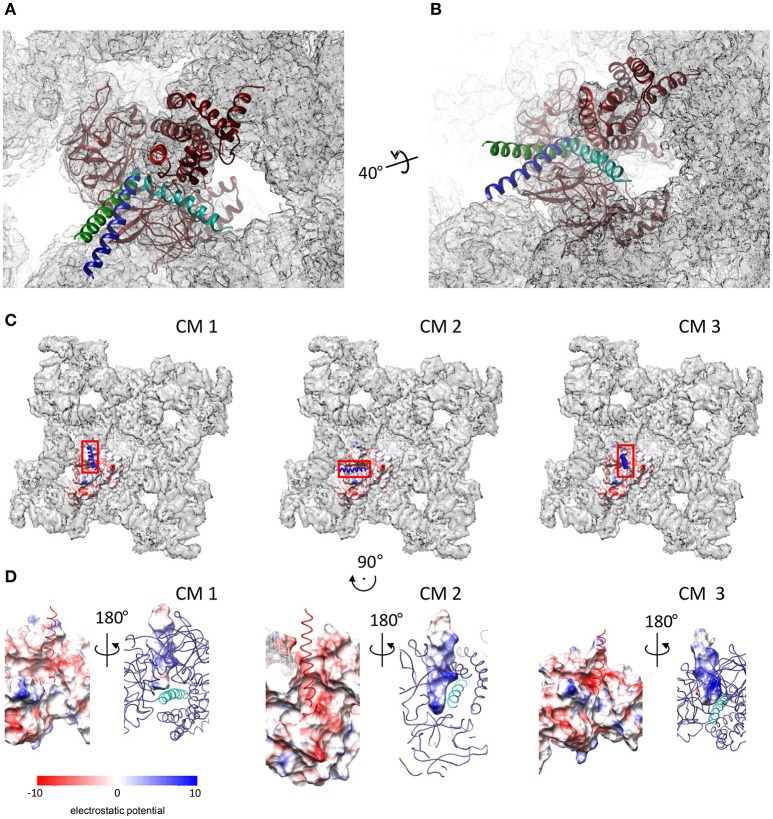
Complexes of DPcpvtN2 with the NTR. (A,B) Two views on the plausible positions of DPcpvtN2 in the complex with NTR. (A) A view along the central helix. (B) Oblique view. The models are positioned in the cryo-EM map of oRyR1 (EMD 2807; Yan et al., 2015). The axis and angle of rotation of the second view are shown. Models CM 1–CM 3 are shown in blue, cyan and green, respectively. (C) Top views of the ryanodine receptor (EMD 2807) with the docked models of NTR in the open state, shown as electrostatic potential distribution (blue, positive; red, negative) of its surface, and with bound DPcpvtN2 shown as a ribbon. Left to right: CM 1, CM 2, and CM 3. The rectangles correspond to the areas shown in (D). (D) Electrostatic potential distribution of the interacting interfaces of NTR and DPcpvtN2. Rotation relative to panels in (C) is shown at the top. Left to right: CM 1, CM 2, and CM 3. In each panel, one side of the interface is shown as the electrostatic potential distribution of its surface (left—NTR; right—DPcpvtN2), while the complementary molecule is shown as a ribbon (left—DPcpvtN2; red; right—NTR, blue, with the central helix shown in a lighter shade). The complementary views (left vs. right) were created by 180° rotation around the vertical axis.